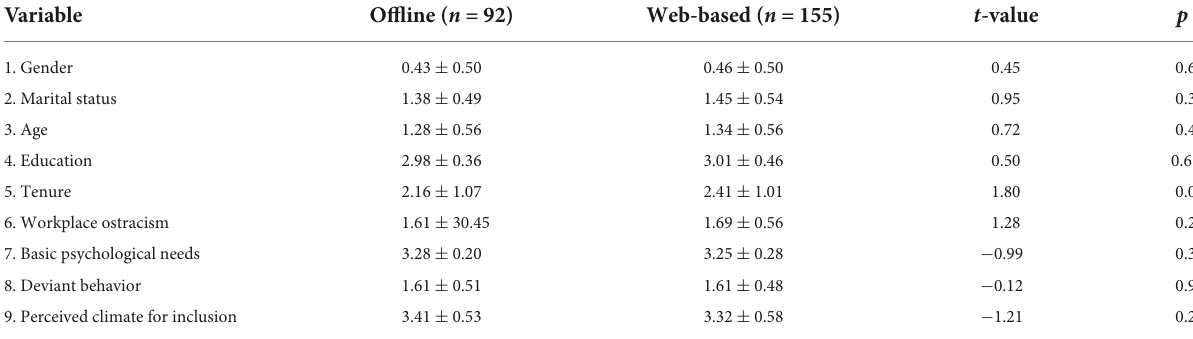
TABLE 1 T -test of offline and web-based surveys.